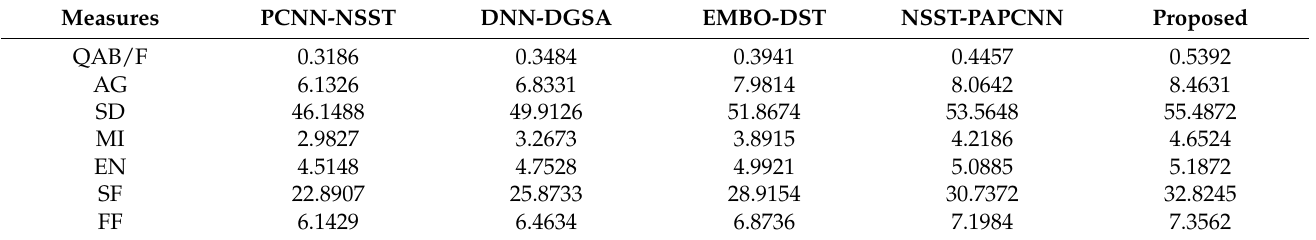
Table 4. Objective computation of various methods on medical image fusion for CT and PET images.